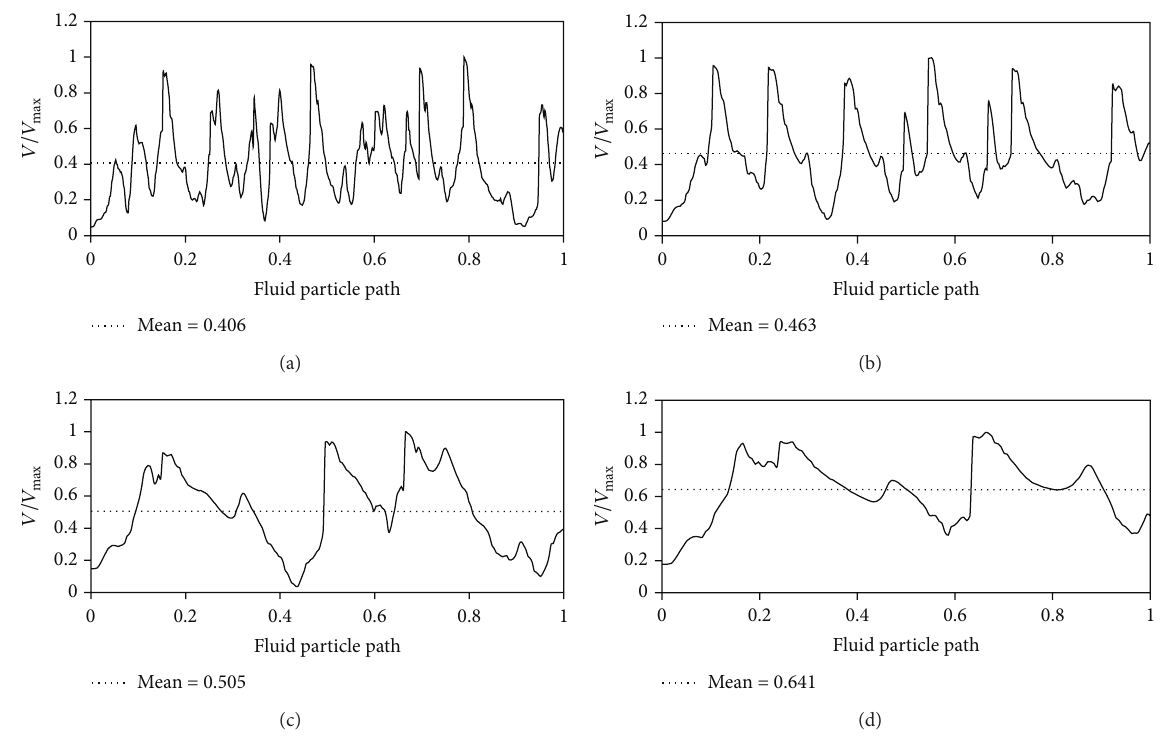
Figure 12: Velocity distribution along fluid particle path. (a) 𝜙/𝜙 𝑛 = 0.3 , (b) 𝜙/𝜙 𝑛 = 0.6 , (c) 𝜙/𝜙 𝑛 = 1.0 , and (d) 𝜙/𝜙 𝑛 = 1.2 .